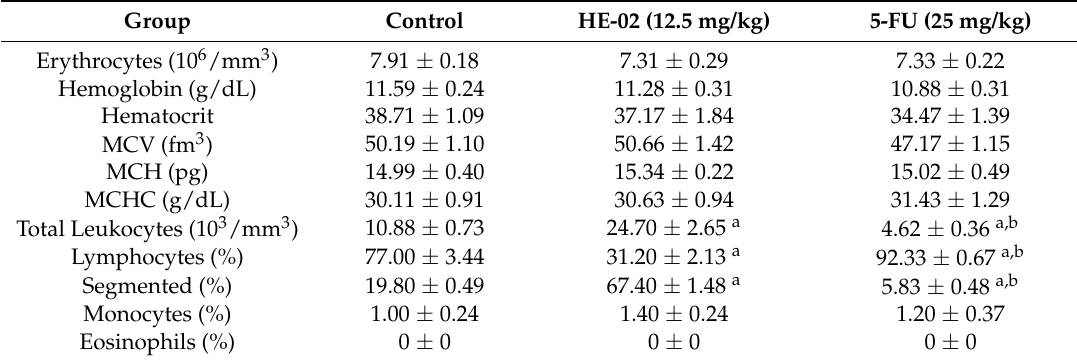
Table 4. Effects of HE-02 and 5-FU on hematological parameters of peripheral blood of mice ( n = 6) subjected to different treatments (9